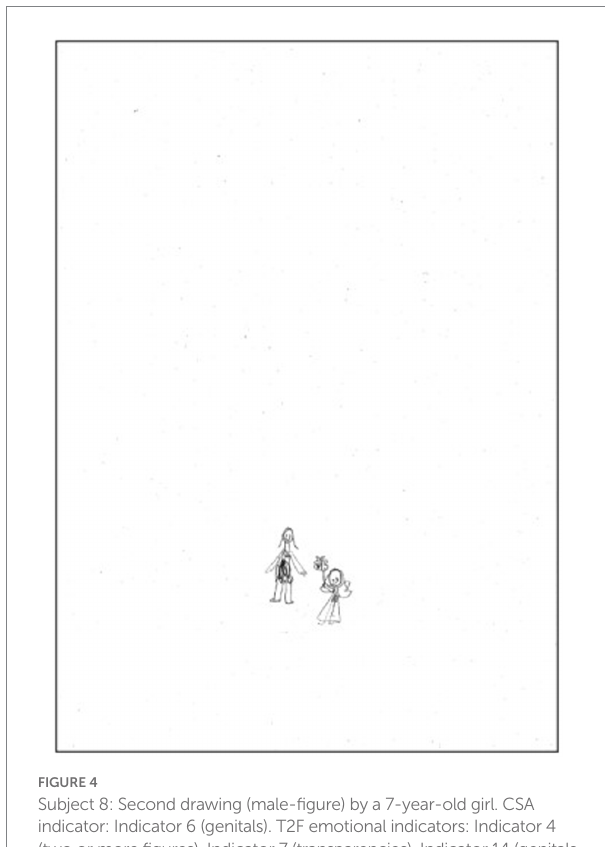
FIGURE 4 Subject 8: Second drawing (male-figure) by a 7-year-old girl. CSA indicator: Indicator 6 (genitals). T2F emotional indicators: Indicator 4 (two or more figures), Indicator 7 (transparencies), Indicator 14 (genitals or emphasised sexual features) and Indicator 17 (shading of